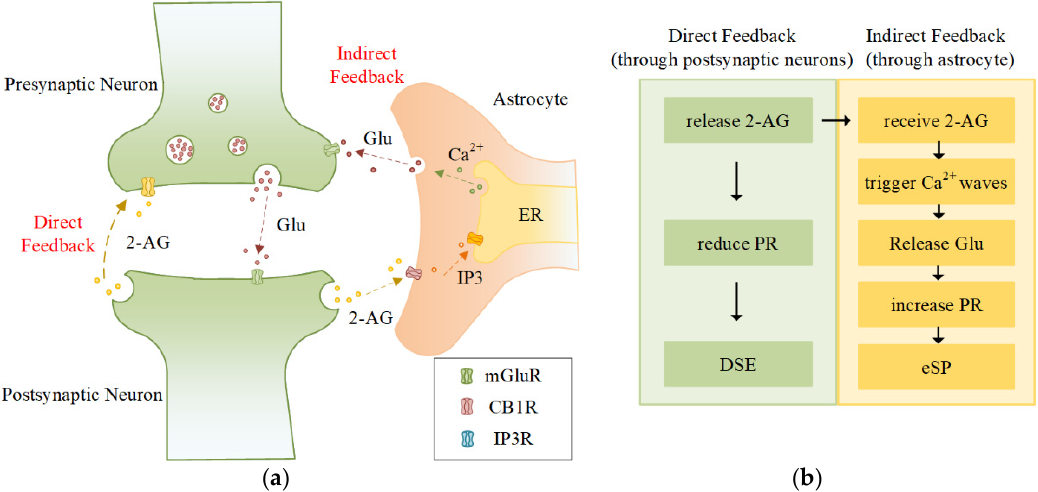
Figure 1. ( a ) The astrocyte-mediated tripartite synapse model (adapted with permission from Ref. [28]. 2018, Liu, J); ( b ) Simplified functional diagram of tripartite synaptic.